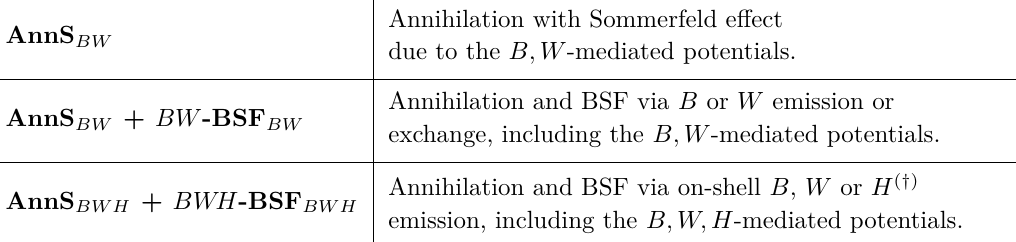
to BSF as the interval between the two occurrences when d 2 (ln Y ) /d (ln x ) 2 = 0 , and